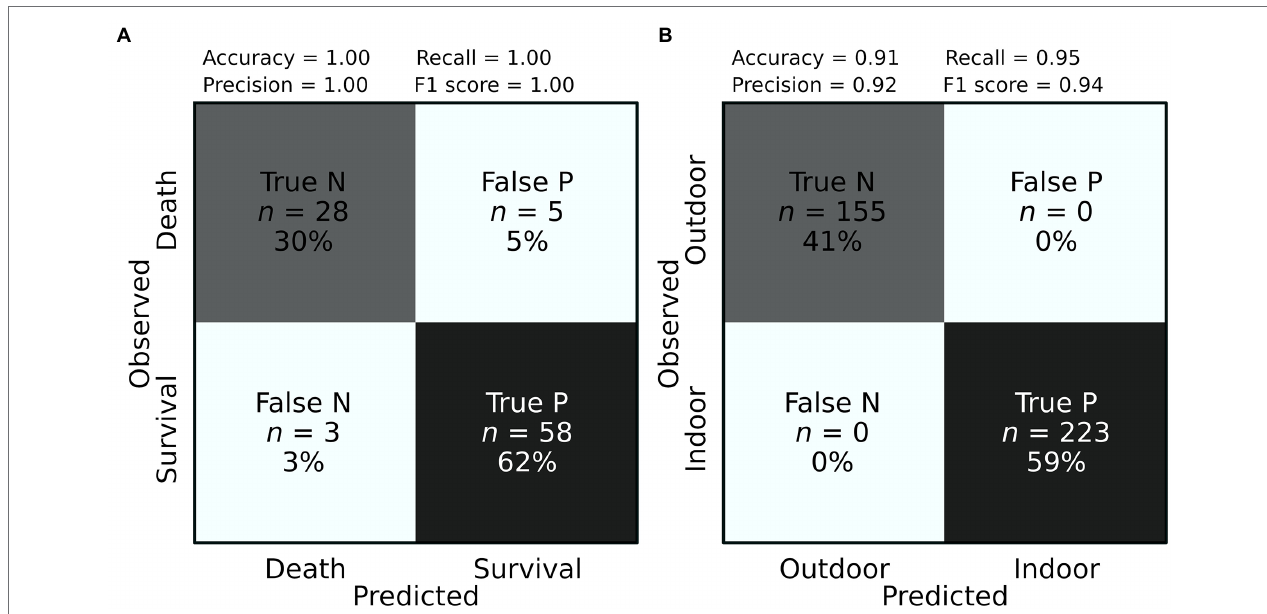
FIGURE 2 | Prediction accuracy of plant survival and growth conditions. Confusion matrices showing the classification performance for the prediction of (A) plant survival (positive P) and mortality (negative N), and (B) the growth condition: indoor (positive P) vs. outdoor (negative N). Precision score = true P/(false P + true P). Recall score = true P/(false N + true P). Accuracy Score = (true P + true N)/(true P + false N + true N + false P). F1 Score = 2*Precision score*Recall score/(Precision score + Recall